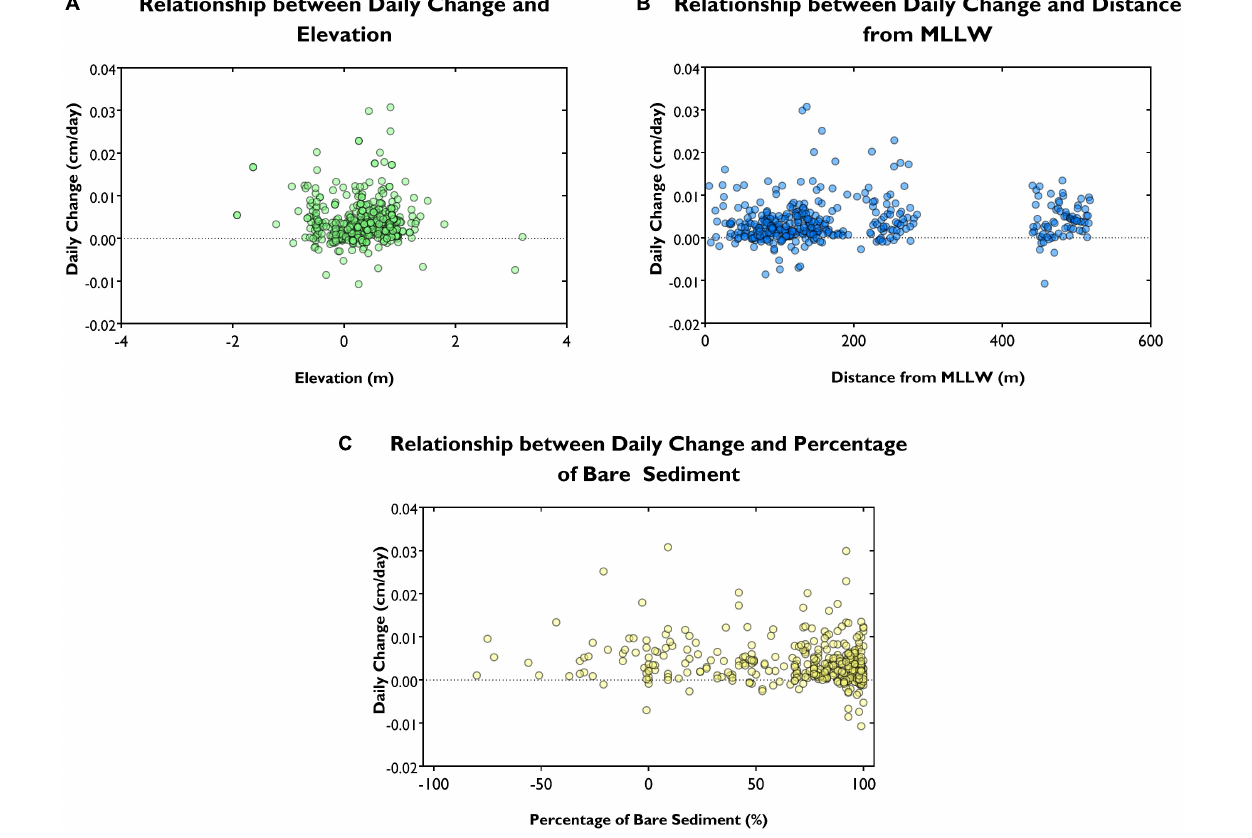
mudflat. This pattern was not seen at other sites. On